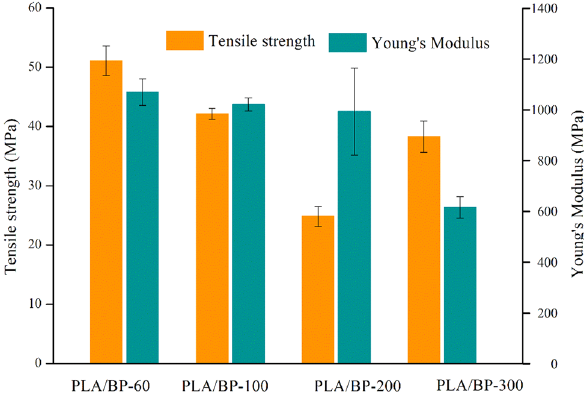
Figure 4: Tensile properties of PLA/BP biocomposites reinforced by BP with di ff erent PSD.